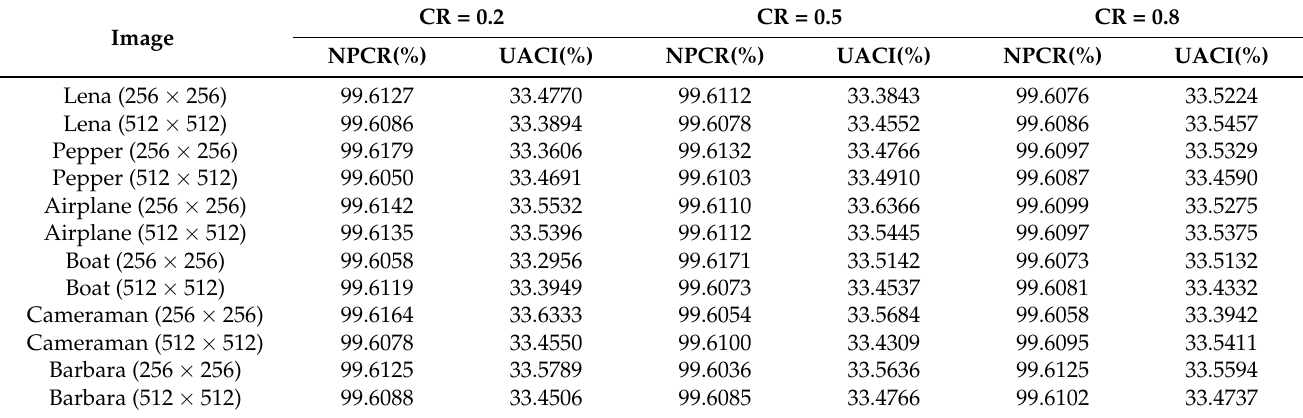
Table 3. Number of pixels change rate (NPCR) and unified average changing intensity (UACI) results. CR = Image